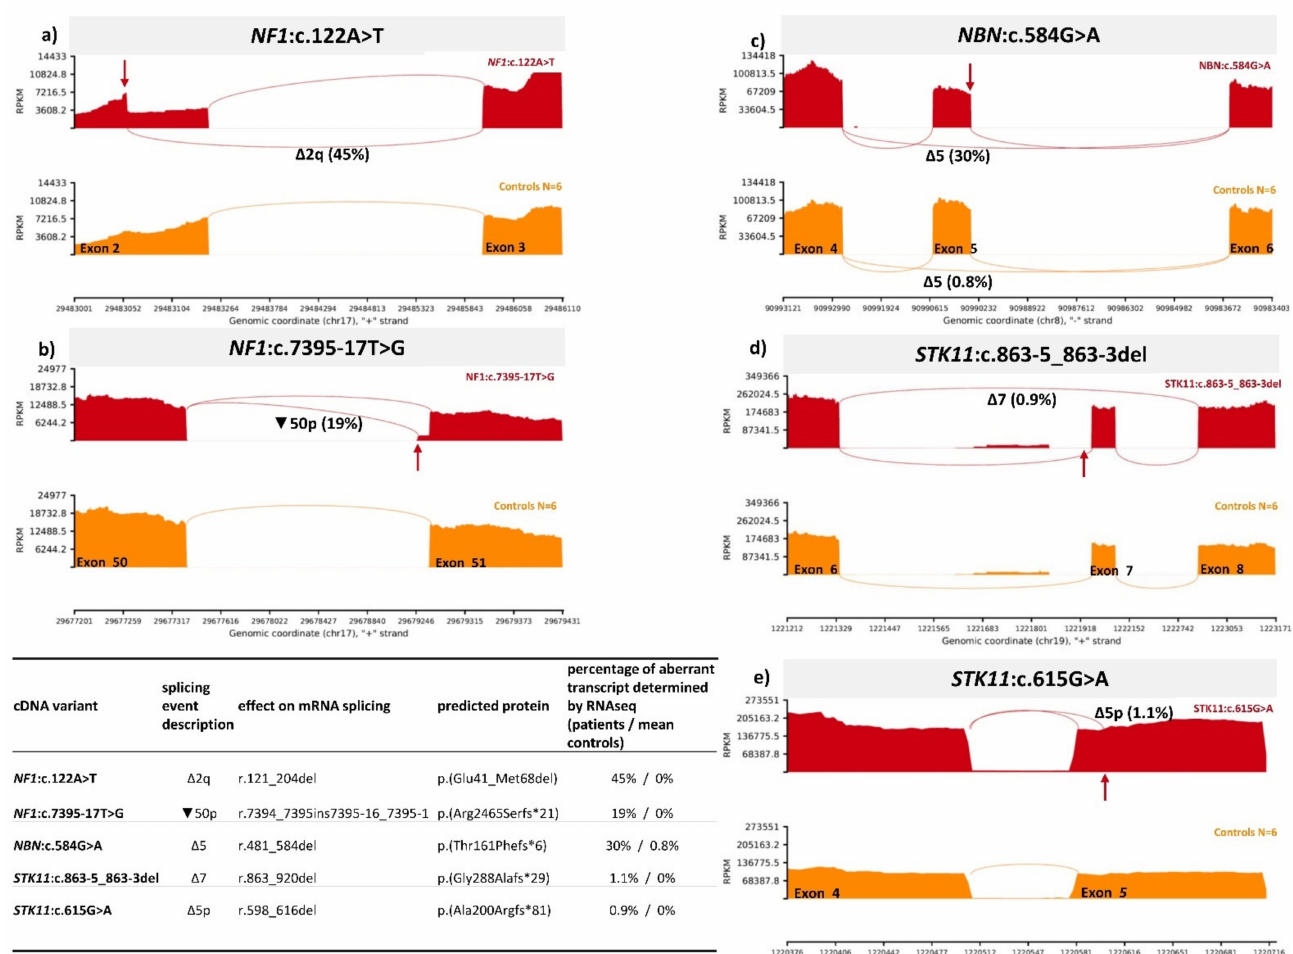
Figure 3. Sashimi plots, representing the splicing impairment caused by variant ( a ) NF1 :c.122A>T ( b ) NF1 :c.7395-17T>G ( c ) NBN :c.584G>A p.(Ser195Asn) ( d ) STK11 :c.863-5_863-3delCTC ( e ) STK11 :c.615G>A p.(Ala205=). Red arrows label variant’s location. Red sashimi plots represent carriers. Orange plots represent control samples (N = 6). Junctions without label are normal transcripts; junctions with labels represent aberrant